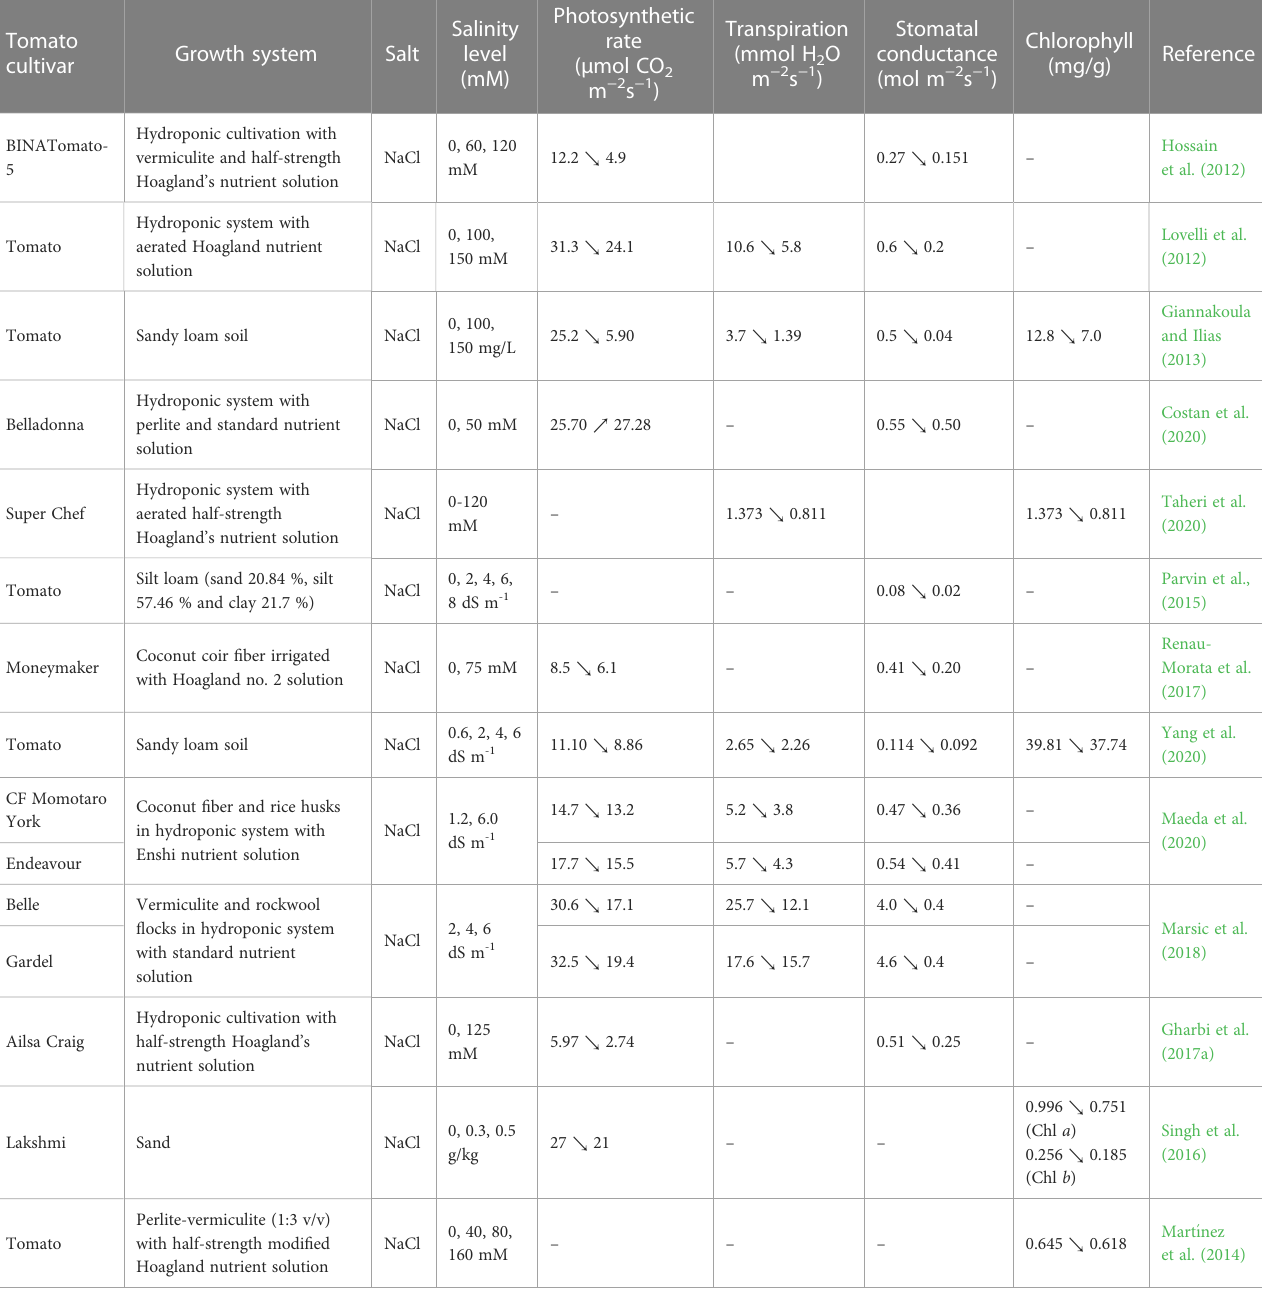
TABLE 2 Photosynthetic rate, transpiration, stomatal conductance and chlorophyll content in tomato leaves under salinity stress.